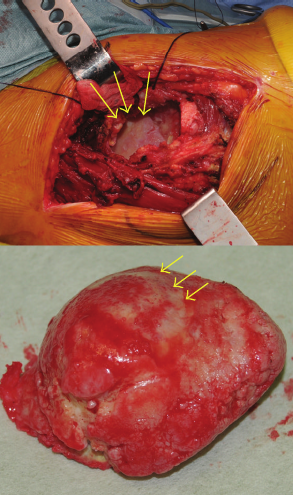
Figure 4: Photograph of the right femoral head in situ and after removal. The acetabular side cartilage and femoral head cartilage showed degeneration